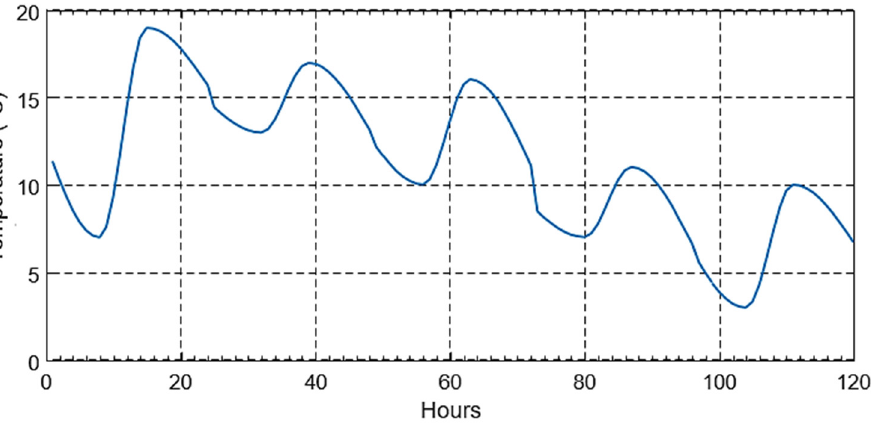
Figure 39. The Wave model simulates the daily ambient temperature cycle for the first five days of November.